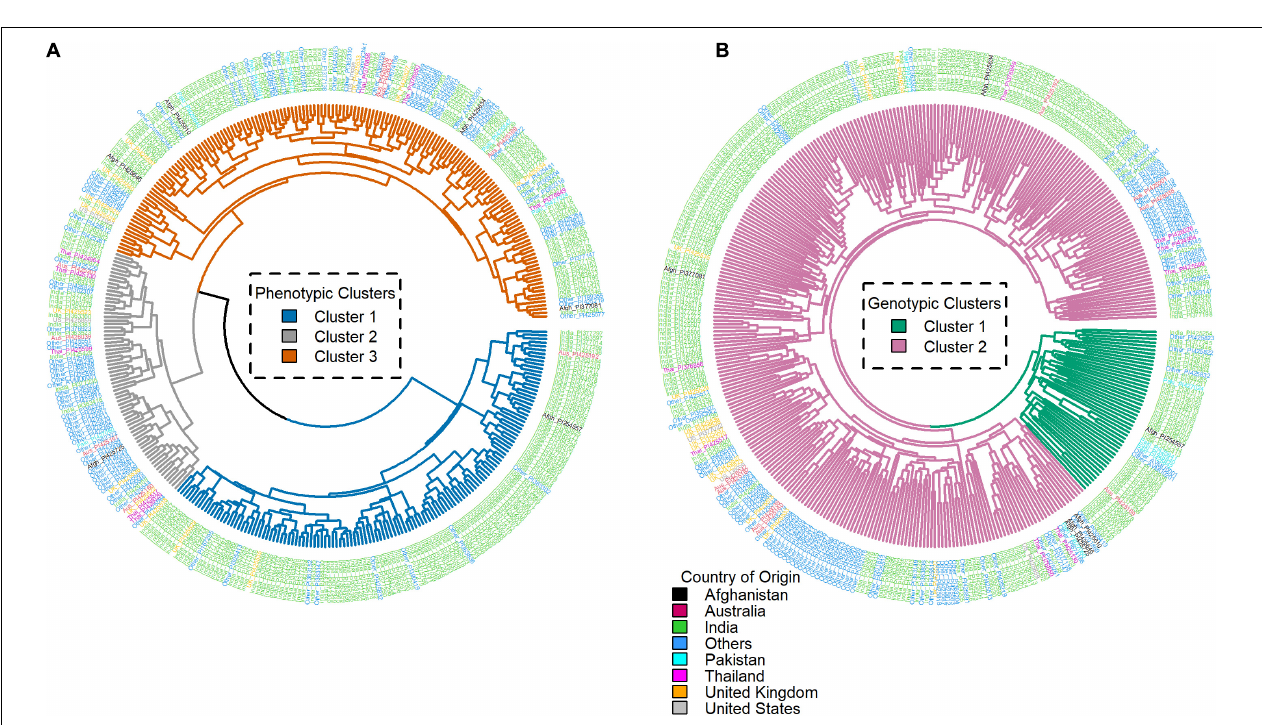
FIGURE 4 | Mung bean iRoot ideotypes, (A) top two genotypes in the topsoil foraging and (B) top two genotypes in the steep, cheap, and deep after ranking the genotypes in the IA mung bean panel.